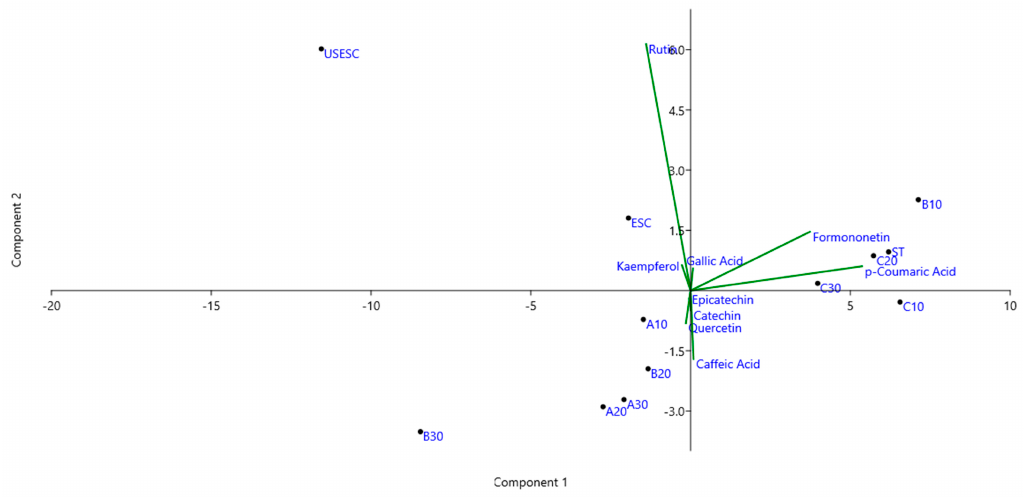
Figure 3. Principal component analysis of the samples obtained by different extraction methods according to the amount of phenolic compounds by HPLC.